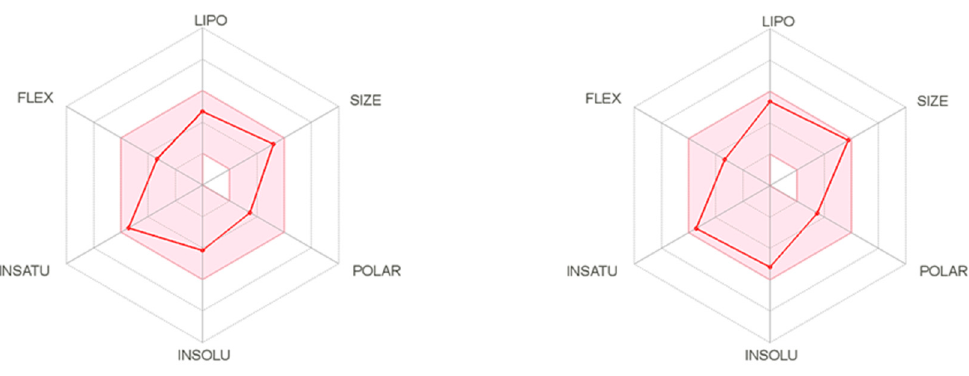
Figure 2. The bioavailability radar of compounds 6 ( left ) and 19 ( right ).